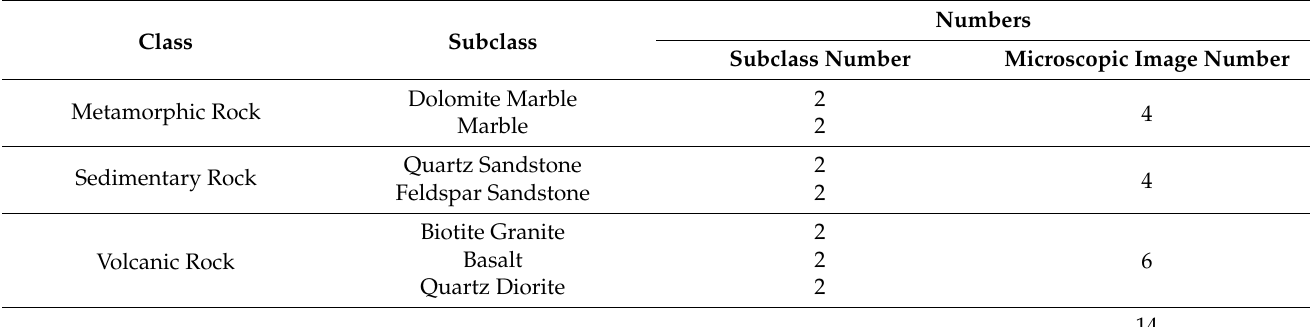
Table 10. Detailed descriptions of the validated datasets.